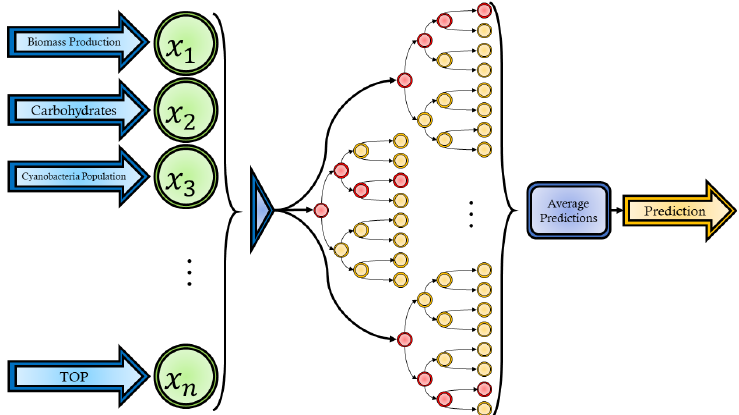
Figure 6. Flowchart for the Random Forest